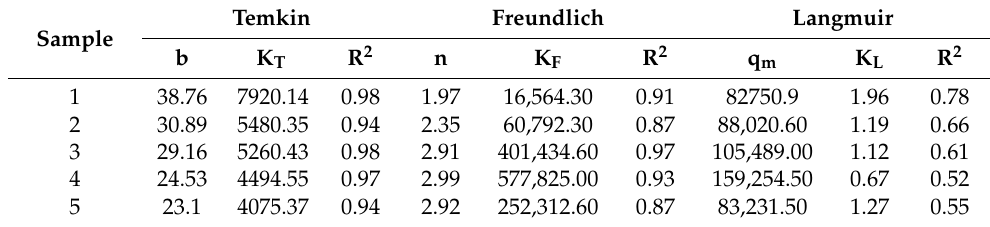
Table 3. Temkin, Freundlich, and Langmuir model parameters.